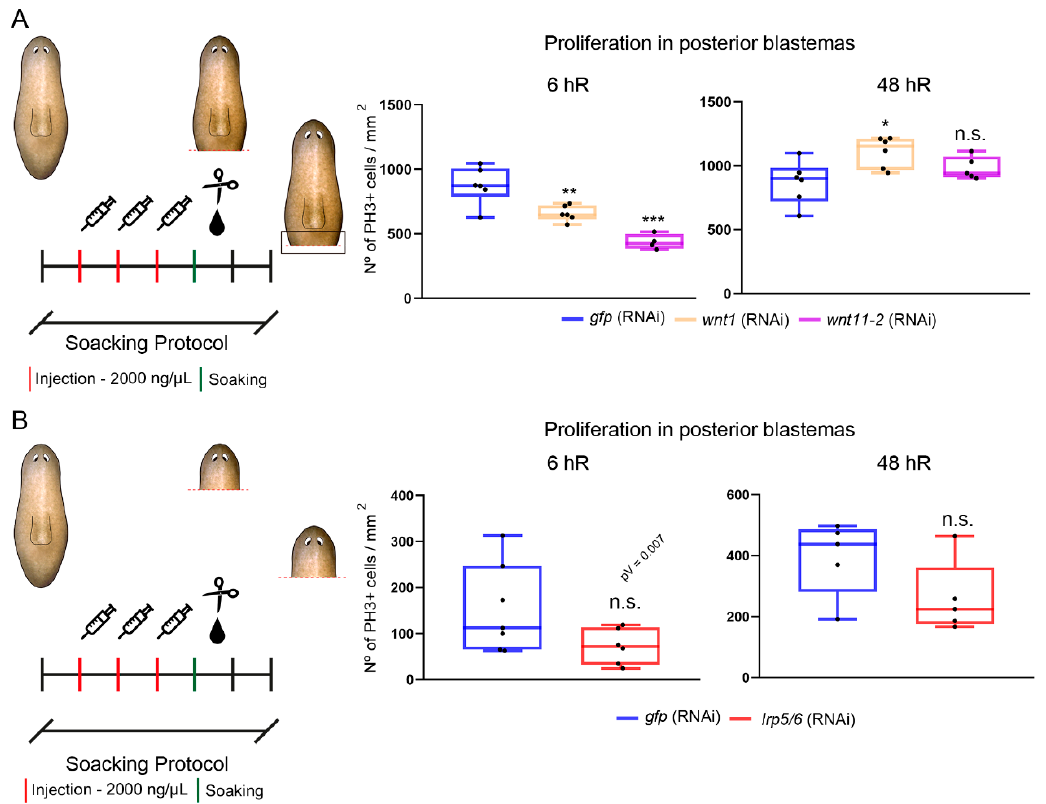
Figure 4. wnt1, wnt11-2, and lrp5/6 (RNAi) animals show proliferative changes during posterior regeneration. ( A ) Schematic illustration indicating the RNAi procedure using the soaking protocol. The quantified area and the amputated area of the trunks are indicated with a dark box and dashed red line, respectively. Quantification of PH3+ cells after the soaking protocol at 6 h of regeneration (hR) ( gfp , n = 6; wnt1 , n = 6; wnt11-2 , n = 5; ** p < 0.01, *** p < 0.001) and 48 hR ( gfp , n = 6; wnt1 , n = 6; wnt11-2 , n = 5; * p < 0.05, n.s.). ( B ) Schematic illustration indicating the RNAi procedure using the soaking protocol. The quantified area and the amputated area of the heads are indicated with a dark box and dashed red line, respectively. Quantification of PH3+ cells after the soaking protocol at 6 h of regeneration (hR) ( gfp , n = 7; lrp5/6, n = 6; n.s.) and 48 hR ( gfp , n = 5; lrp5/6, n = 5; n.s.).